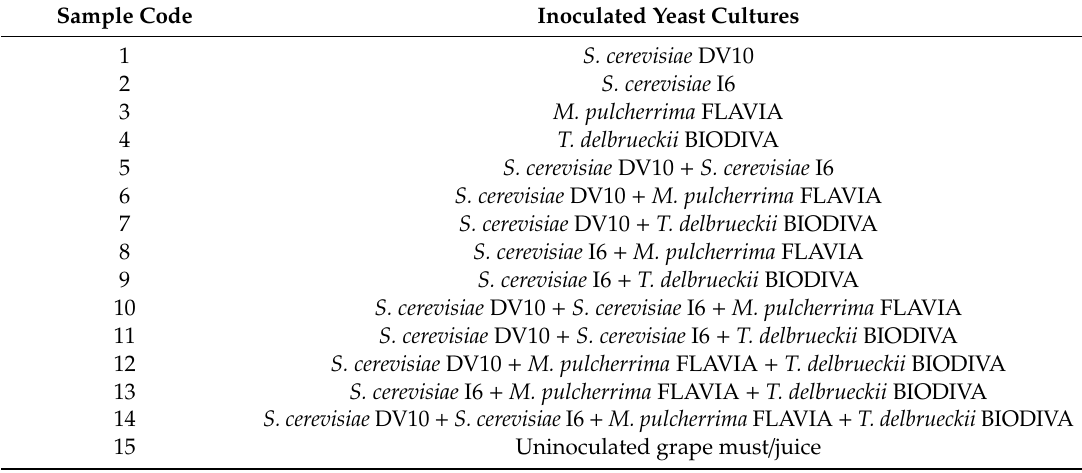
Table 1. Microorganisms employed in di ff erent grape must / juice fermentations (trials 1–15). Sample